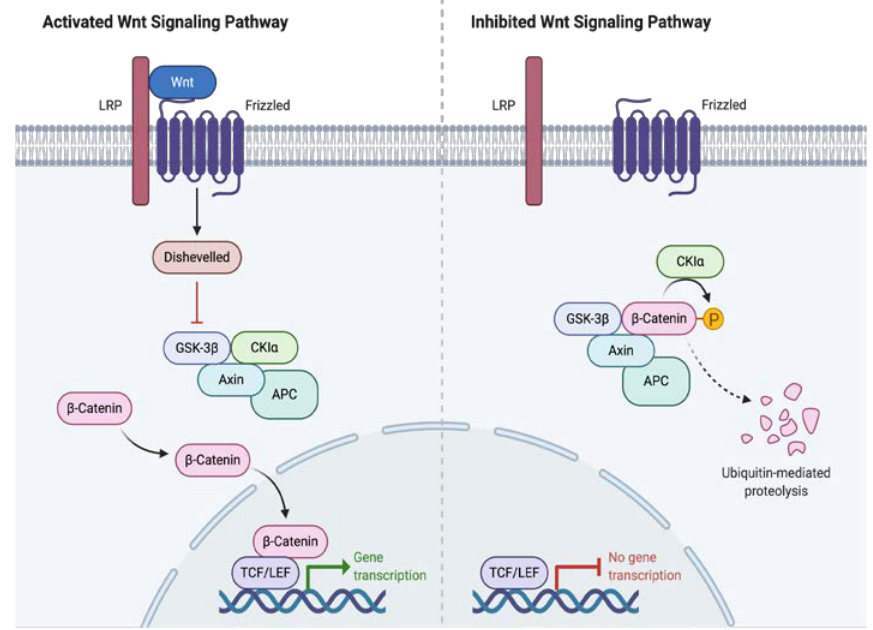
Figure 1. Wnt Signaling Pathway Activation and Inhibition.